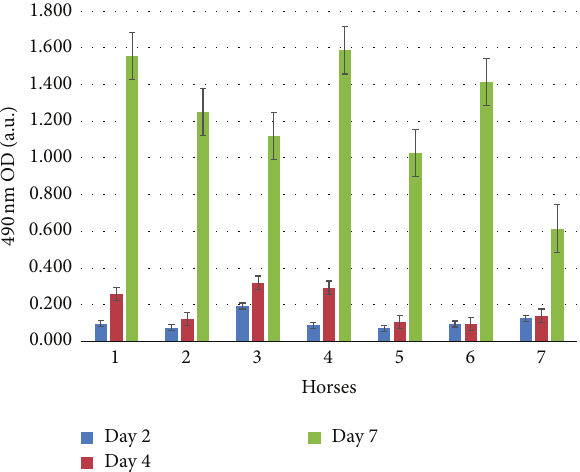
Figure 1: Measurement of rate of proliferation of eBM-MSCs. MTS assay was used to compare the rates of proliferation of eBM-MSCs from 4 young horses (numbers 1–4) and 3 middle-aged horses (numbers 5–7) over a period of 7 days. Absorbance is the optical density (OD) measured at 490 nm with this colorimetric assay. Note the rapid rate of self-renewal on all animals at day 7. Mean values of each sample ( 𝑛 = 7 ) are presented with the standard deviation plotted as the error